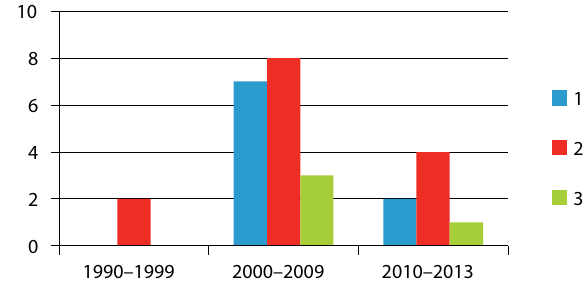
fig. 4. Distribution of research fields and its dynamics